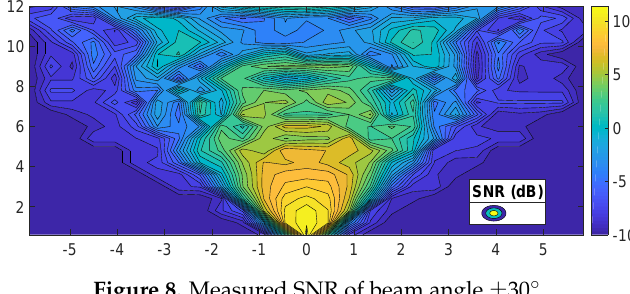
Figure 8. Measured SNR of beam angle ± 30 ◦ .